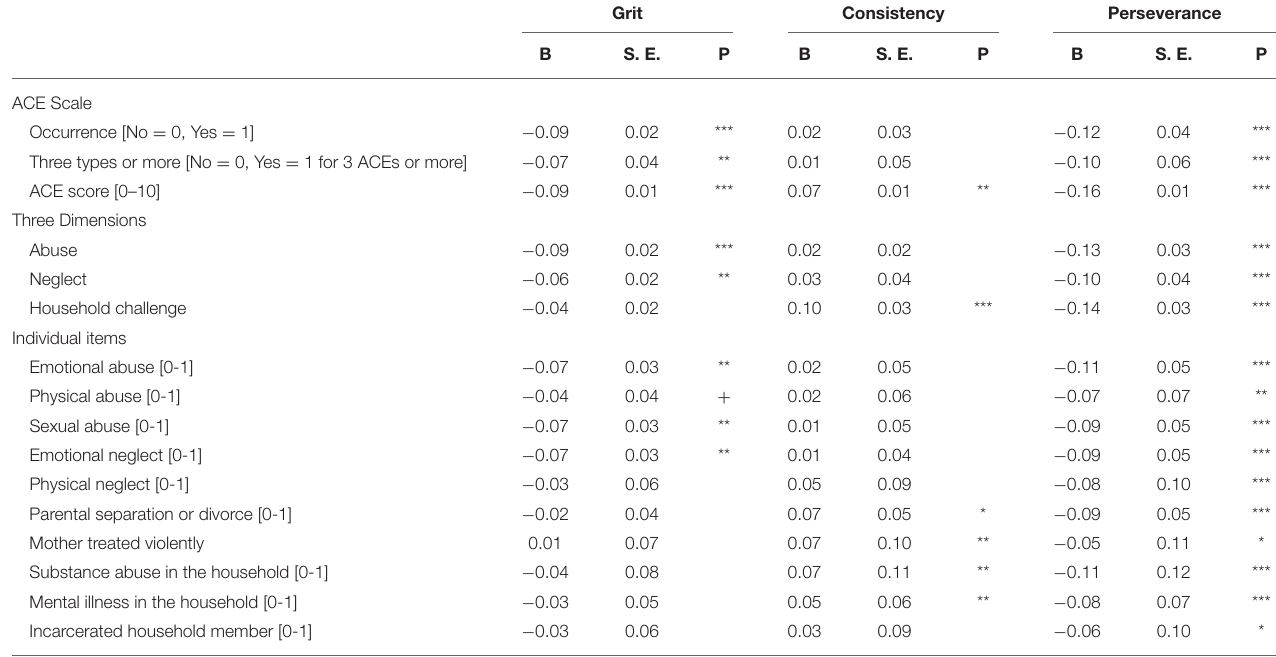
TABLE 4 | Robust tests of ACEs on